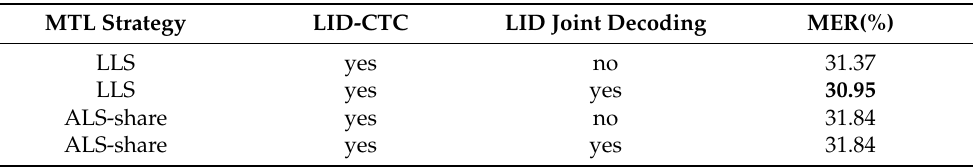
Table 4. MER(%) of ASR task (using CTC-Transformer architecture), corresponding to joint decoding with LID or